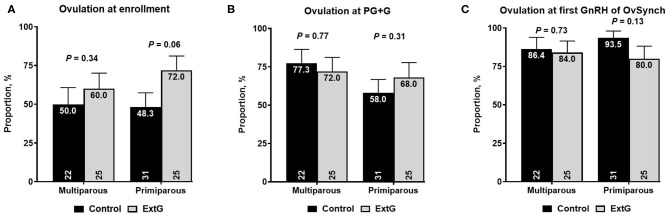
Bar graph illustrating the proportion of cows ovulating (A) at enrollment, (B) at simultaneous PGF2α and GnRH (PG+G), and (C) at first GnRH of OvSynch according to treatment (Control vs. ExtG) in multiparous and primiparous cows. The proportion is listed on the top, whereas the number of cows per treatment is at the bottom. Error bars represent the standard error of the mean.